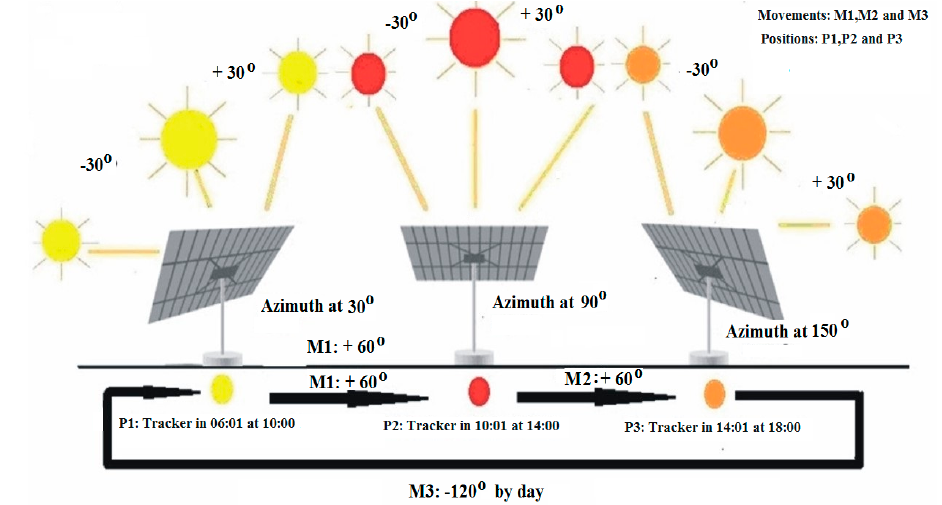
Figure 3. General operation of the solar tracker prototype.